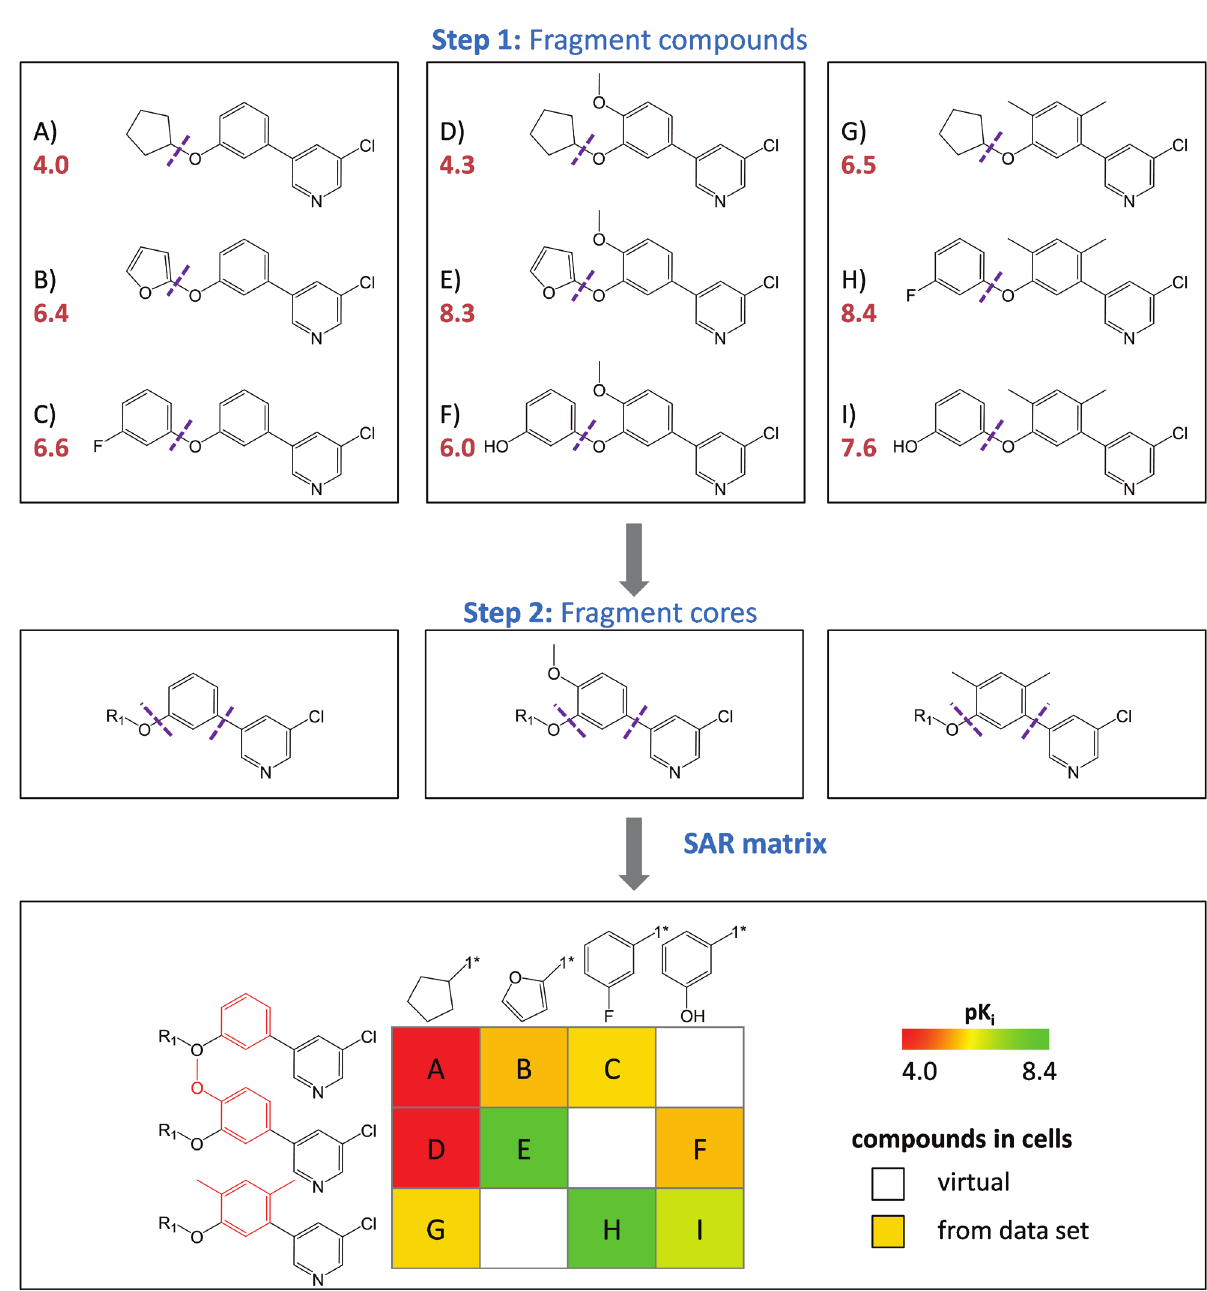
Figure 1. SAR matrix generation. Three model series with three compounds each ( A – C , D – F , and G – I ) are shown with pK the first step, all compounds are fragmented at a single bond (purple dotted line) producing compound MMPs that yield a common core (key) and a compound specific substituents (values). In the second step, the cores resulting from the first step are further fragmented to obtain core MMPs. The SARM is then generated by combining series with structurally analogous cores that represent individual rows. In addition, columns represent substituents. In each cell, the combination of a core and a substituent defines a unique compound. Compounds present in the data set are indicated by filled cells that are color-coded according to potency using a continuous spectrum from red (low potency) over yellow to green (high). In addition, empty cells indicate virtual compounds. Substructures distinguishing the core fragments are highlighted in